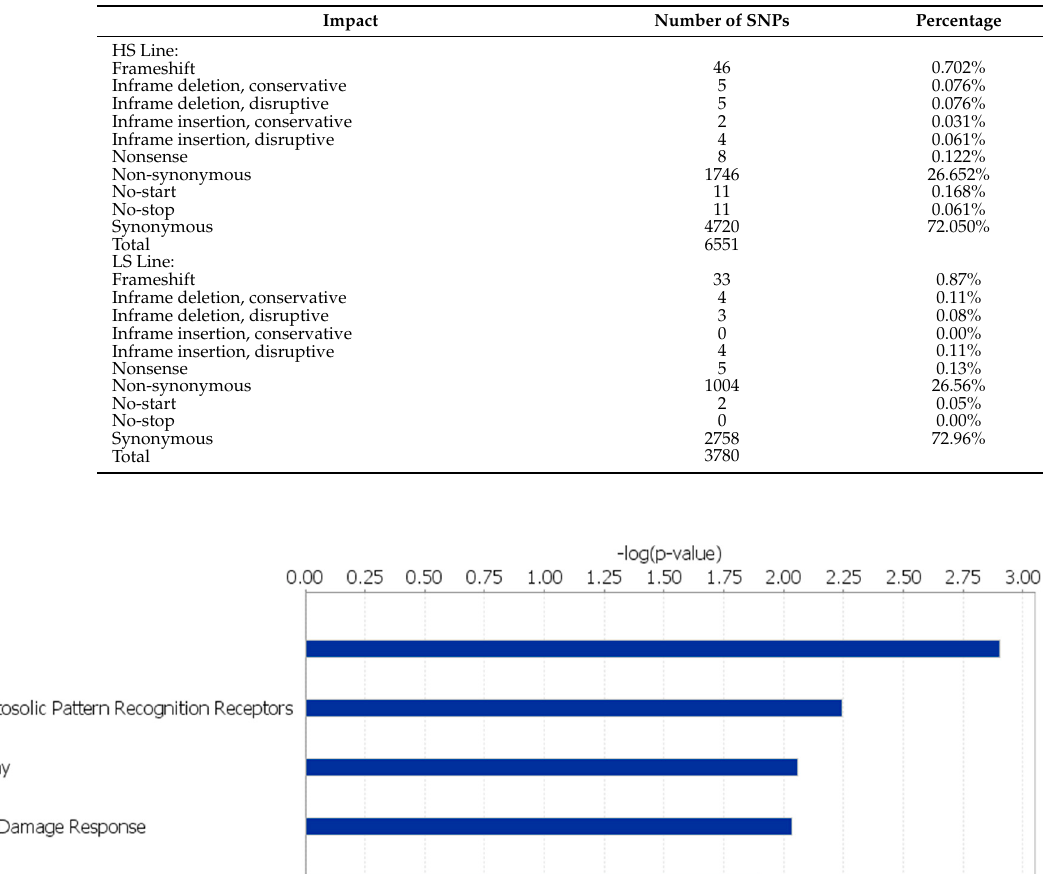
Table 4. Occurrence of unique SNP impacts in HS and LS lines of Japanese quail.